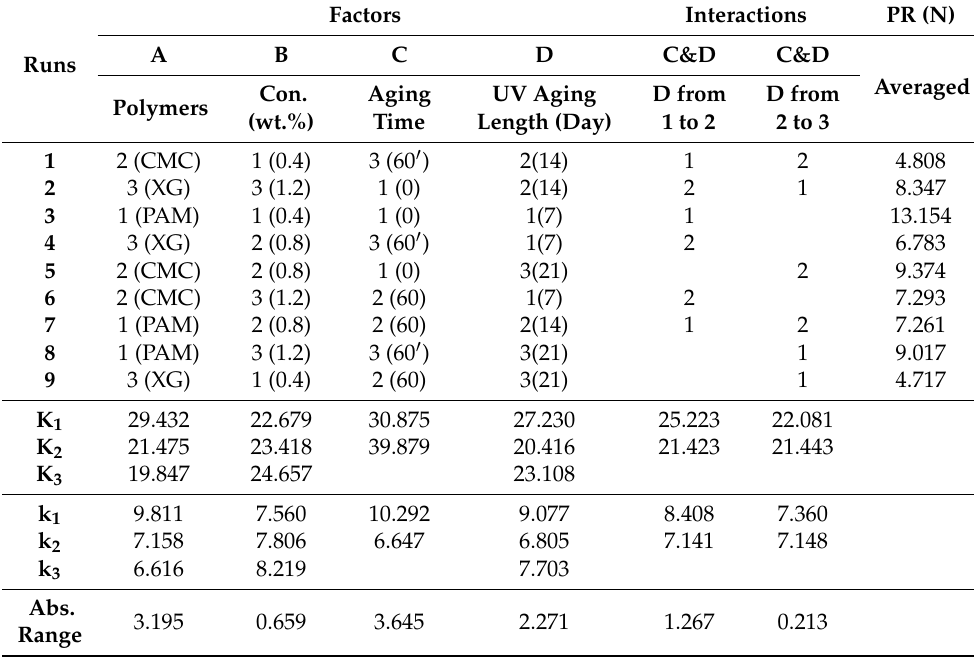
Table 7. Results of ultraviolet radiation aging test for individual polymer